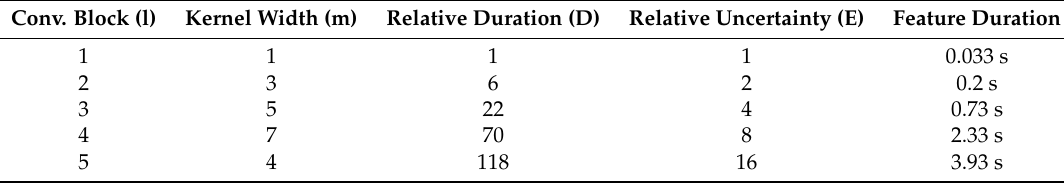
Table 1. Characterisation of the uncertainty (E) and relative duration (D) of the sampled features based on the networks hyper-parameters (l) and